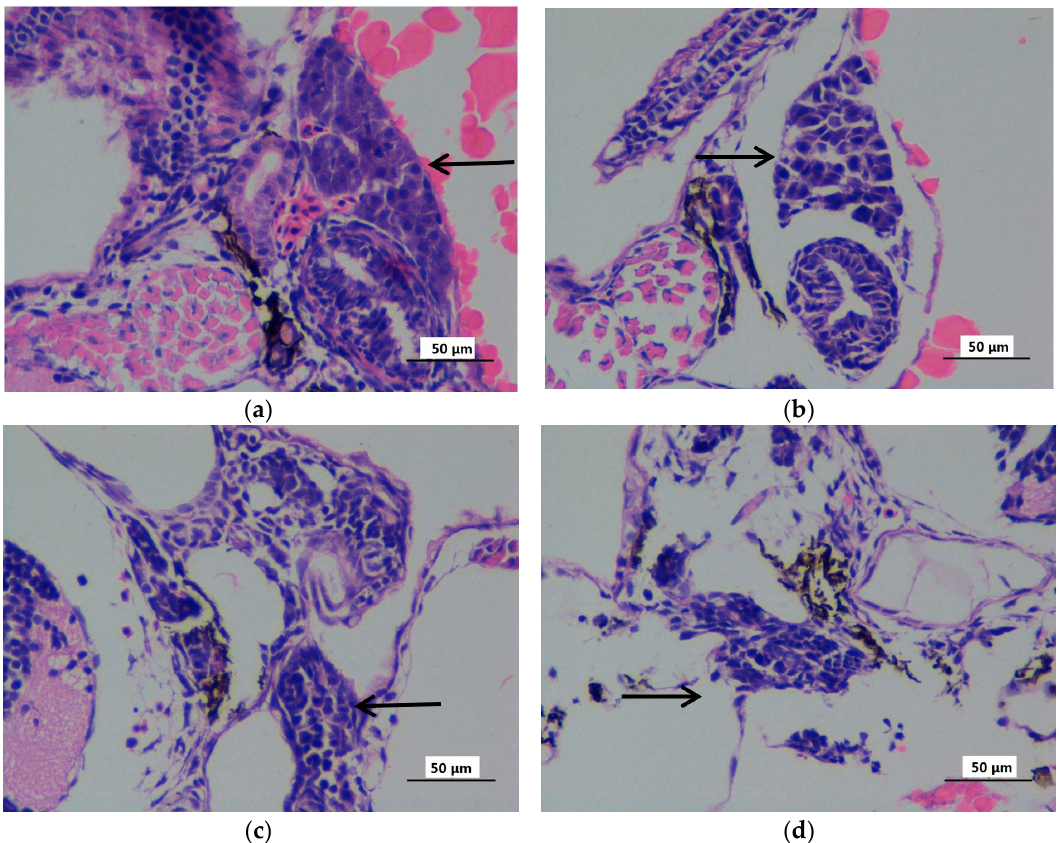
Figure 4. The hematoxylin-eosin staining microphotographs of zebrafish liver (72 hpf) exposed to gradient concentrations of mitoxantrone (×400). The zebrafish embryos exposed to 0 ( a ), 10 ( b ), 50 ( c ) and 100 ( d ) μ g/L mitpxantrone were observed at 72 hpf with hematoxylin–eosin staining. The black arrow indicated the liver tissues. The scale bar indicated 50 μ m.